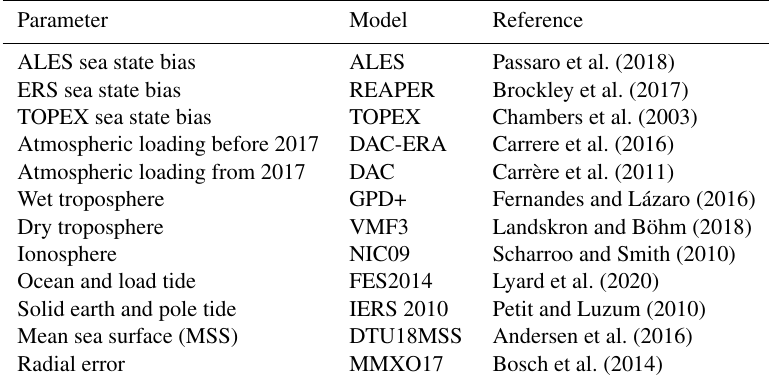
Table 2. List of corrections and parameters used to compute SLA for tidal residuals